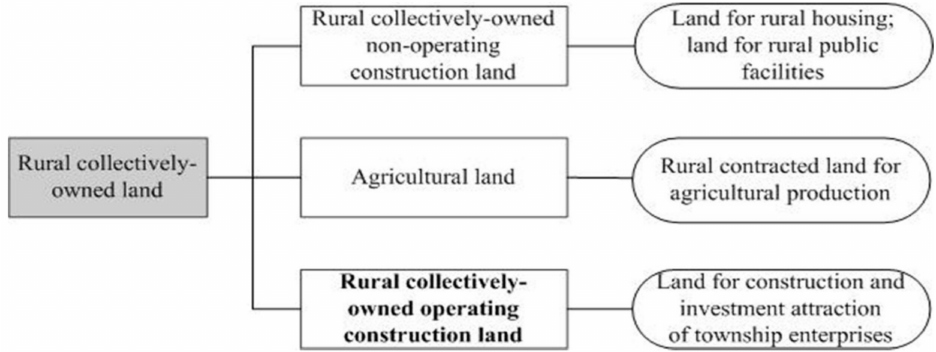
Figure 1. China’s rural land reclassification. Source : According to Zhou, Li, and Liu [26]. RCOCL refers to rural construction land with the nature of production and operation, such as rural collectively owned land used to establish rural (town) enterprises. RCOCL entering the market refers to the process by which the rural land owner transfers the RCOCL use right for a certain period to the right holder in the form of sales, leases, and shares. Land increment income refers to the remaining part of the land transfer fee less the land development